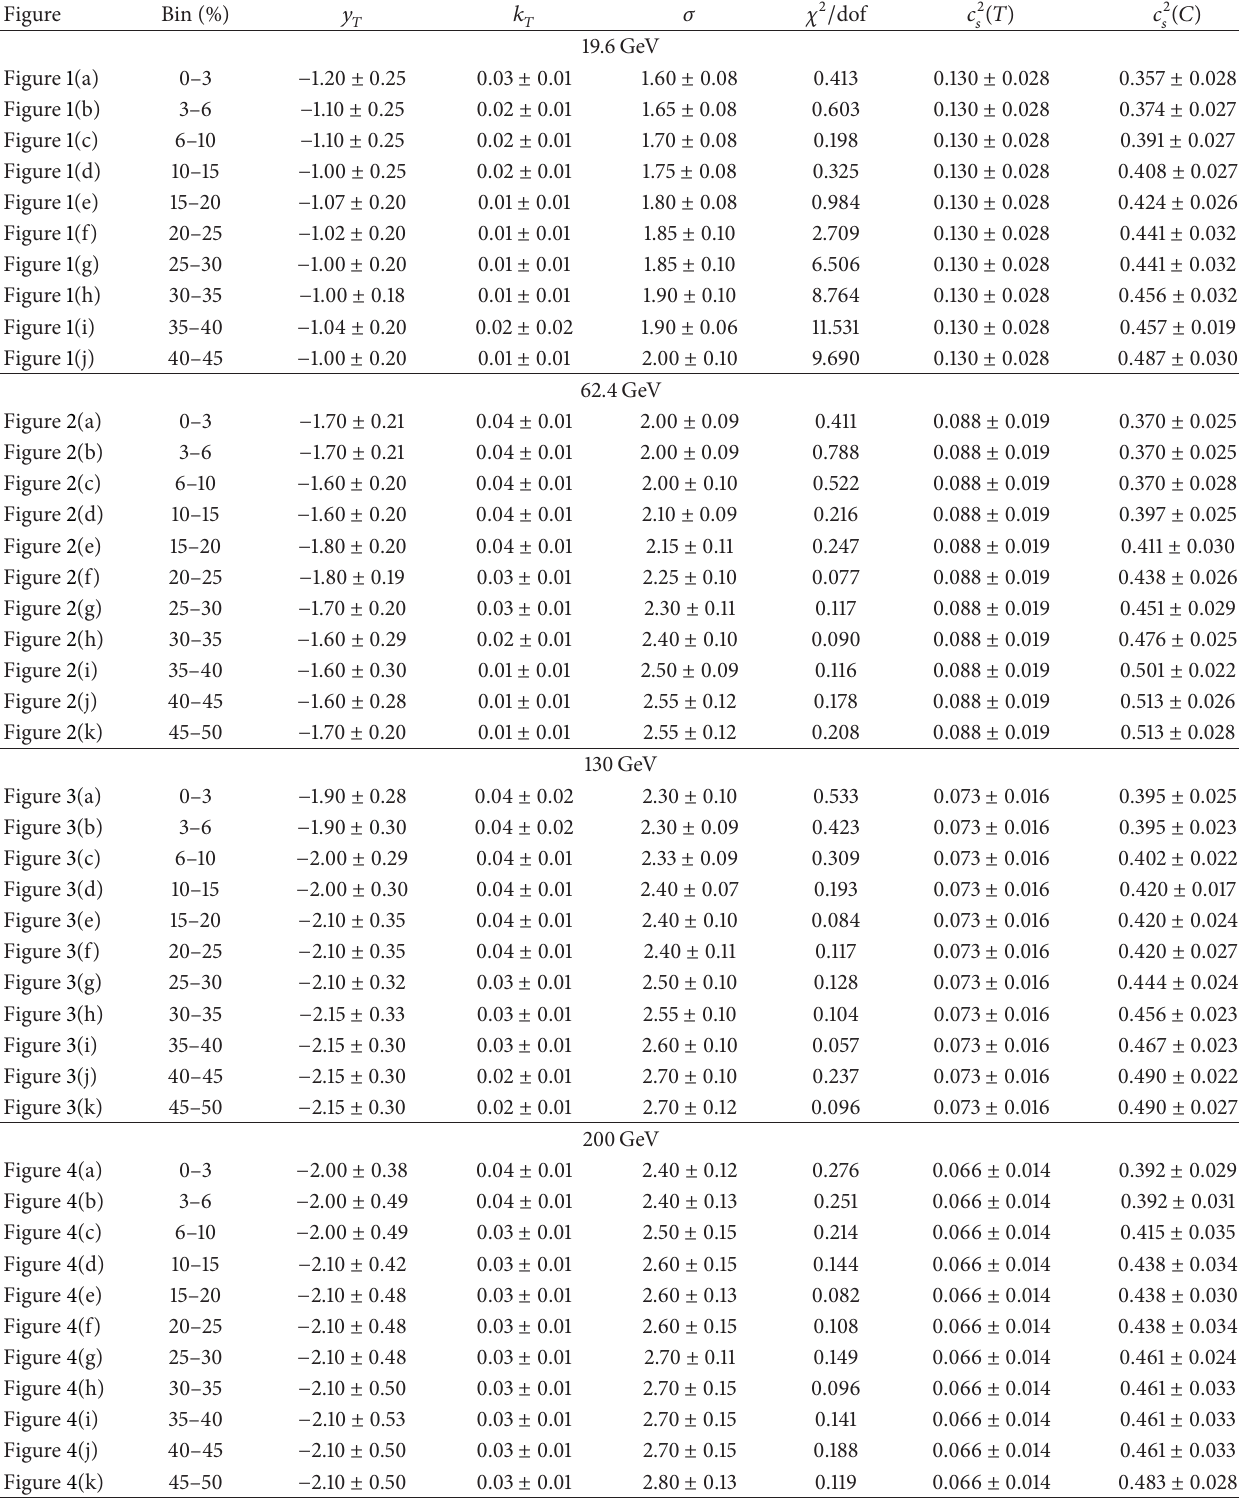
Table 1: Values of peak position 𝑦 𝑇 and contribution ratio 𝑘 𝑇 of the target source, the rapidity distribution width 𝜎 of the central source, and 𝜒 2 / dof for the curves in Figures 1–4 which show Au-Au collisions for different energies and centralities. For the symmetric collisions, the peak position 𝑦 𝑃 and contribution ratio 𝑘 𝑃 of the projectile source and the peak position 𝑦 𝐶 and contribution ratio 𝑘 𝐶 of the central source can be given by 𝑦 𝑃 = −𝑦 𝑇 , 𝑘 𝑃 = 𝑘 𝑇 , 𝑦 𝐶 = 0, and 𝑘 𝐶 = 1 −𝑘 𝑇 −𝑘 𝑃 , respectively. The last two columns show the values of square speed of sound for the target [𝑐 2 𝑠 (𝑇)] or projectile [𝑐 2 𝑠 (𝑃) = 𝑐 2 𝑠 (𝑇)] and central sources [𝑐 2 𝑠 (𝐶)] ,